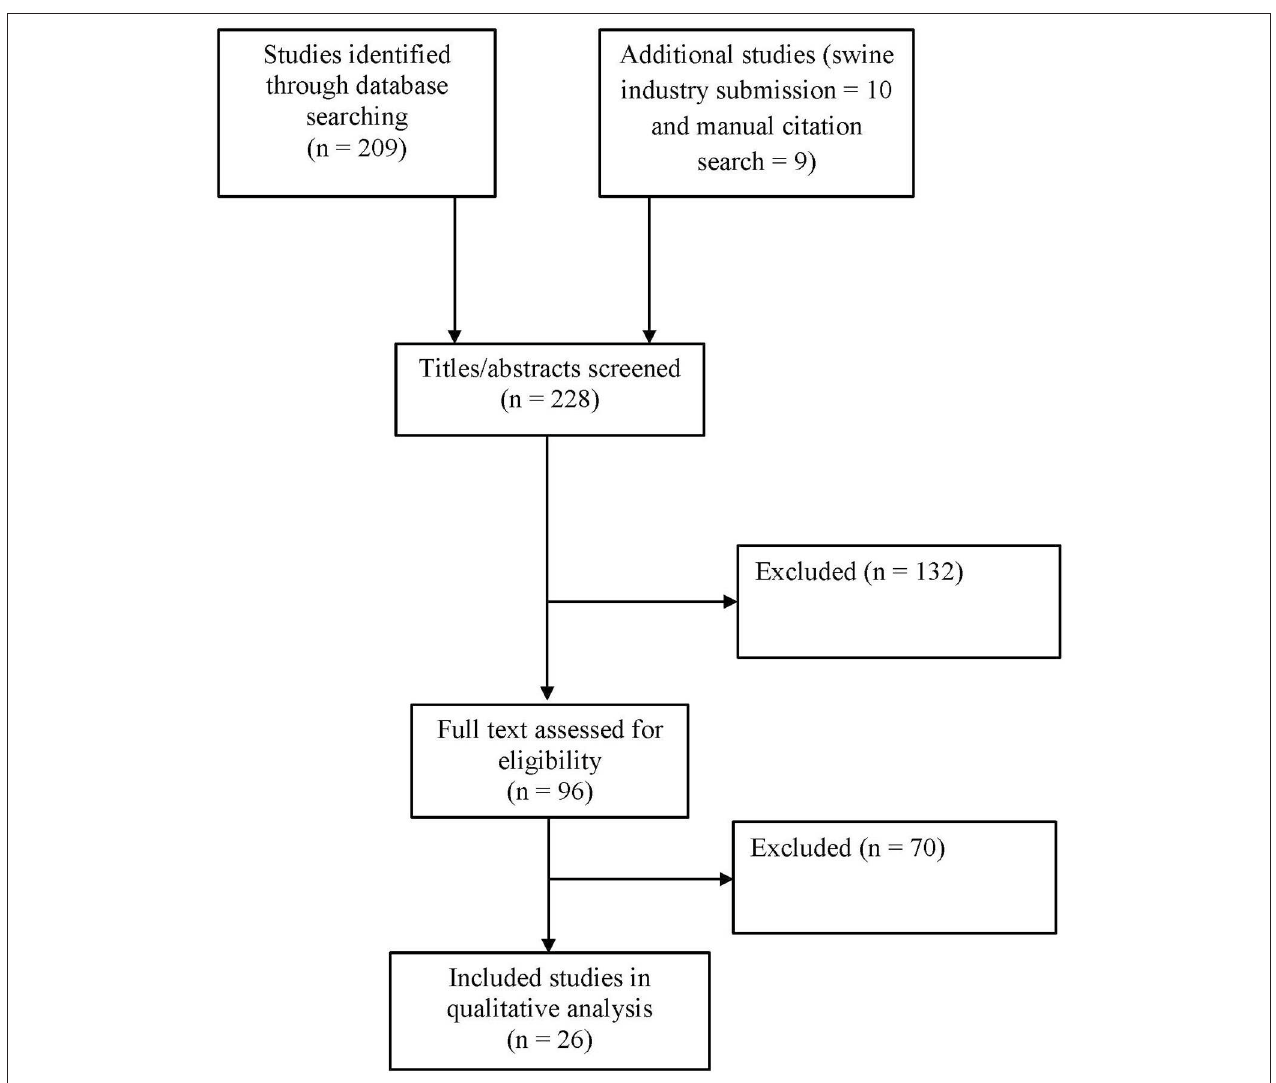
FIGURE 1 | Overview flow chart of study selection